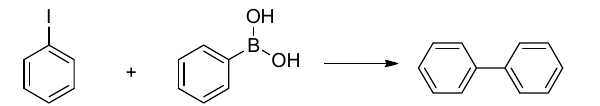
Figure 6. The biphenyl yield in the reaction of iodobenzene and phenylboronic acid in different solvents using Ni catalyst prepared with continuous ultrasound treatment (30 W output power) and at reflux temperature.